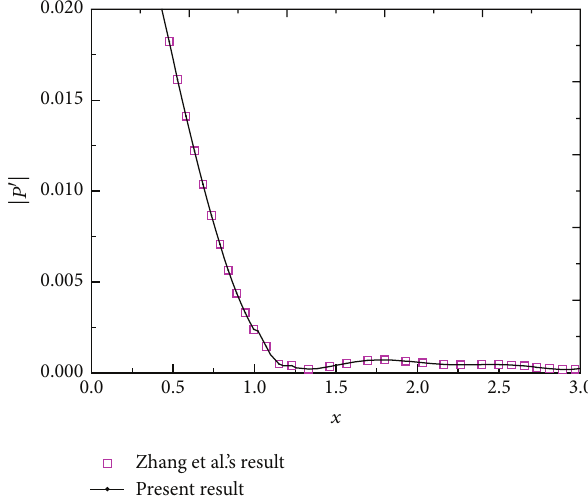
Figure 1: Amplitudes of the second harmonic mode of pressure disturbance in the boundary layer are compared with Zhang et al.’s result [21,